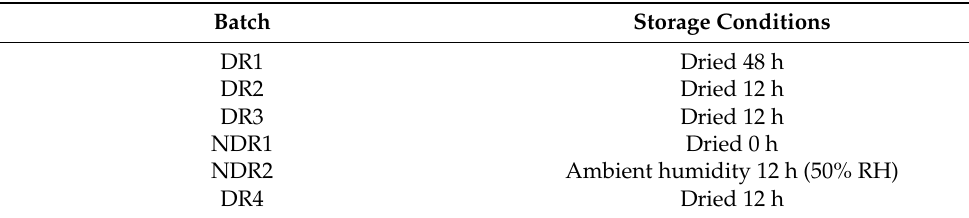
Table 2. Batch storage conditions before filament production.